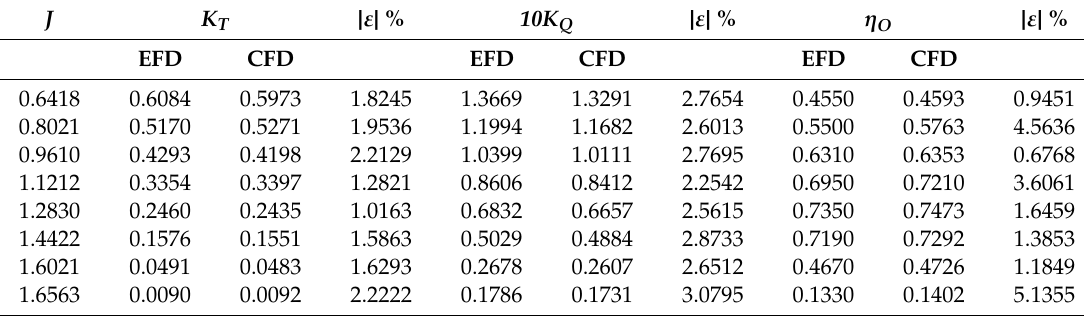
Comparison between the open water propeller performance coe ffi cients measured and